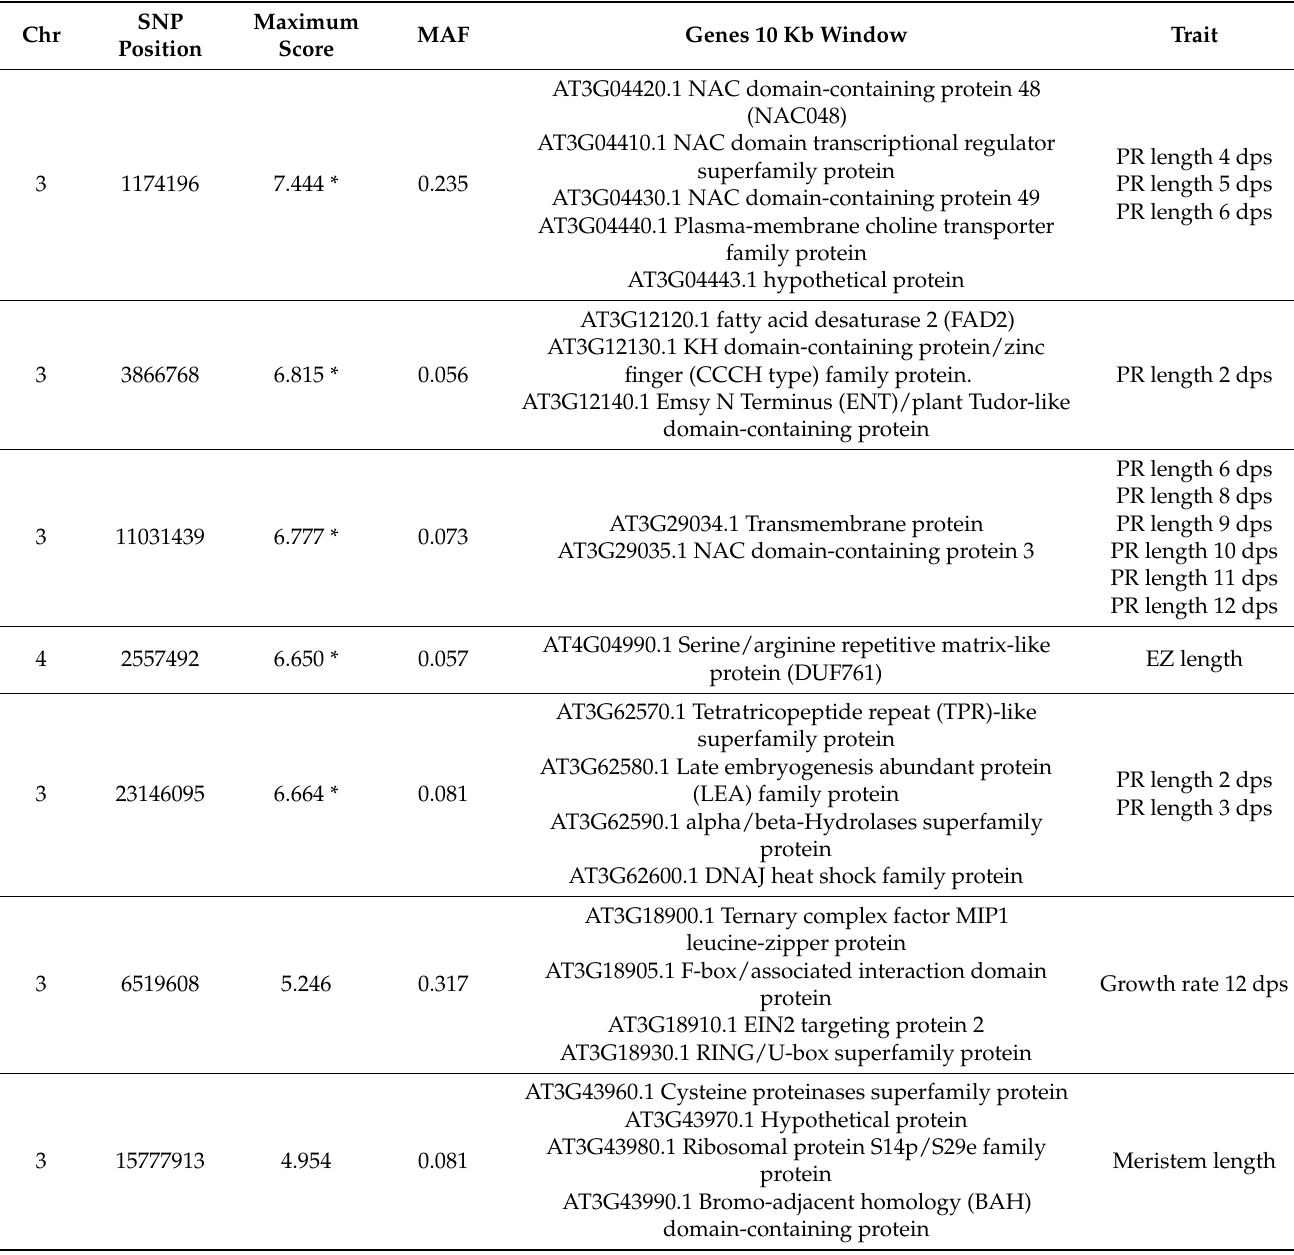
Table 1. List of the 23 Genes Identified by GWAS within a 10 kb